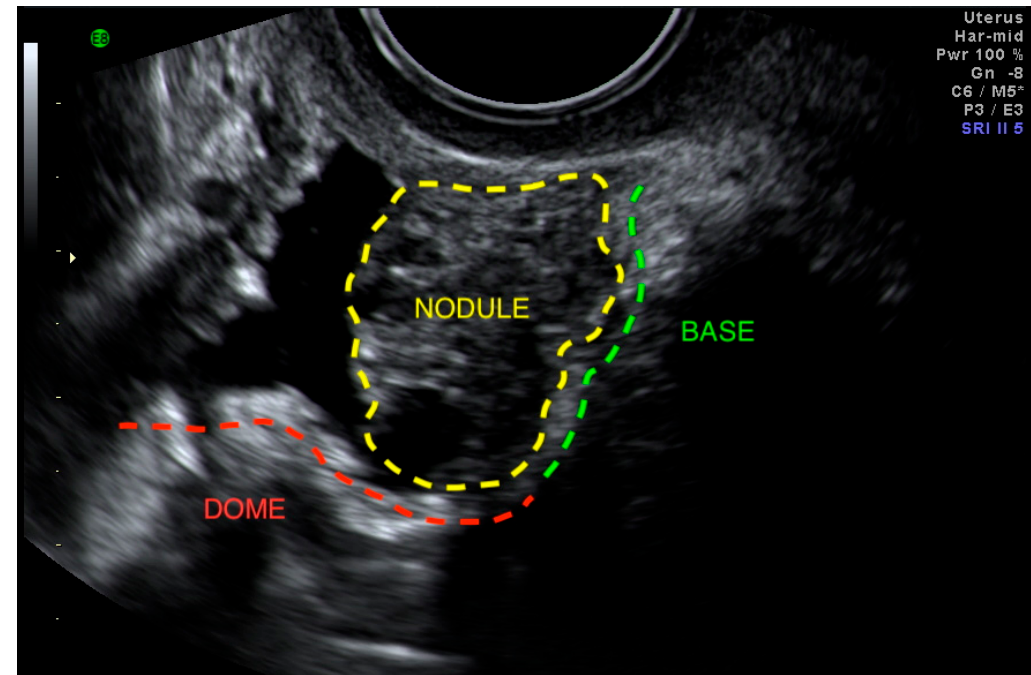
Figure 2. Transvaginal ultrasound depiction of the bladder. ( A ) Normal bladder and ( B – D ) three bladder deep endometriosis nodules, identified with white arrows.